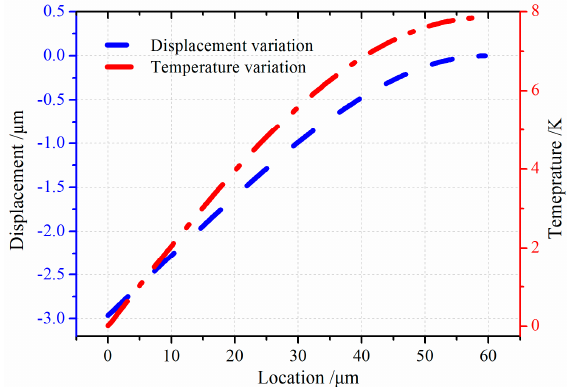
Figure 6. Field quantities variation under transverse vibration.